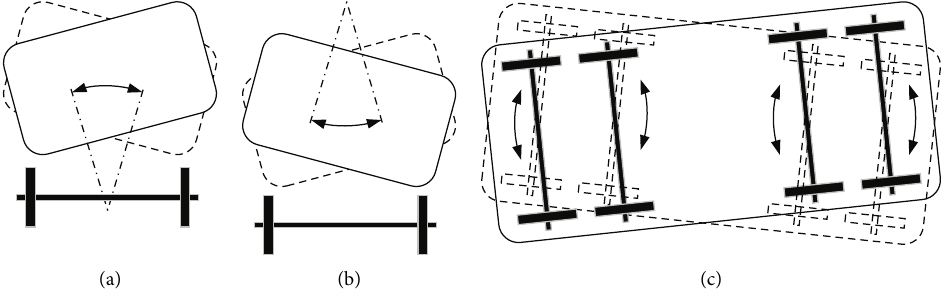
Figure 16: Lower swaying mode, upper swaying mode, and carbody hunting mode of the vehicle. (a) Lower swaying. (b) Upper swaying. (c) Carbody